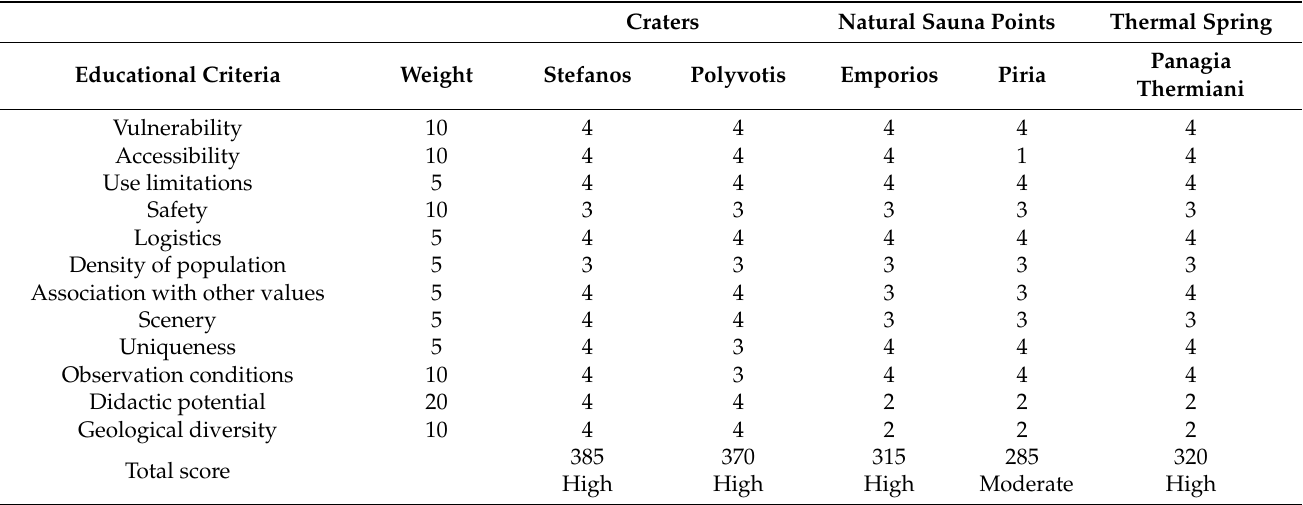
Table 3. Quantitative evaluation of geosites for educational potential use